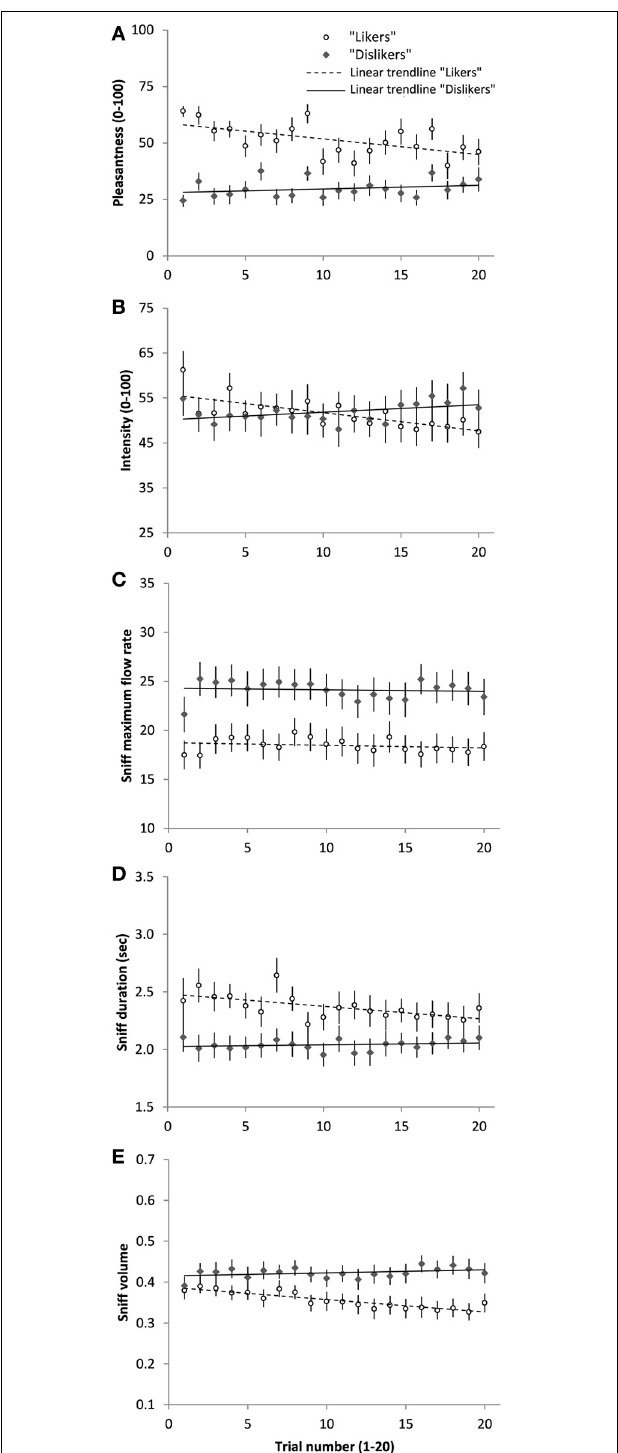
FIGURE 2 | Average hedonic ratings (A), intensity ratings (B), sniff maximum flow rate (C), sniff duration (D), sniff volume (E) (Mean ± s.e.m) of the “likers” and “dislikers” for the odors of anise and chocolate together, on each of the 20 repeated odor presentations. The linear trend curve of each participant group is presented. Slopes and results of the linear regressions are shown in Table 1